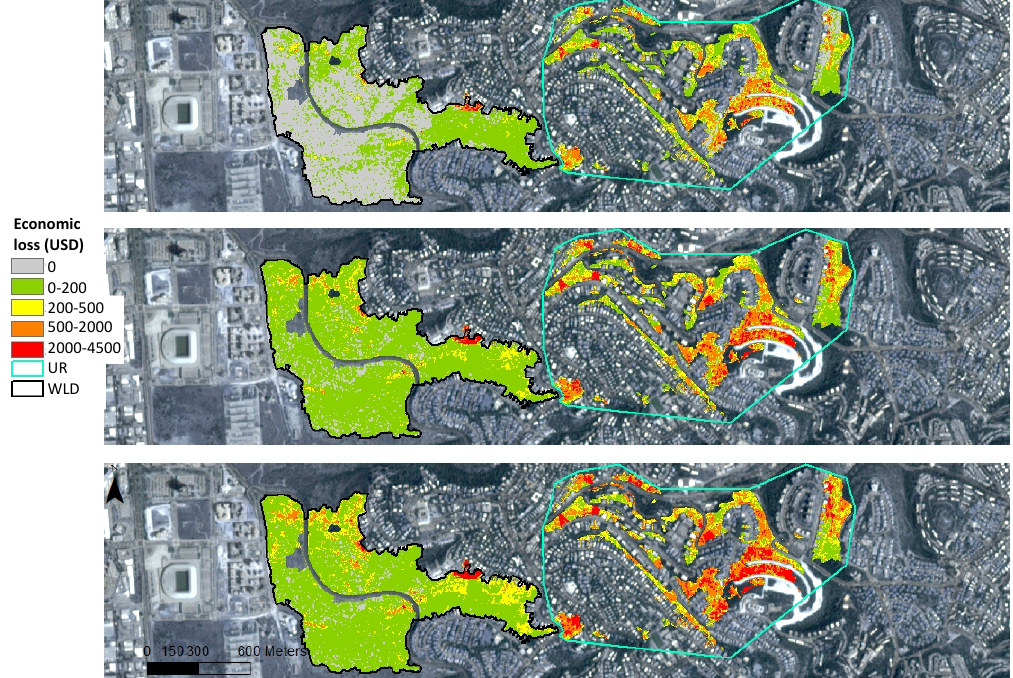
Figure A5. Maps of low-to-high estimates of the environmental economic loss due to burned trees (in USD) in the WUI: using low stand density estimates (upper map); using mean estimates of stand density (middle map); and using high stand density estimates (bottom map).